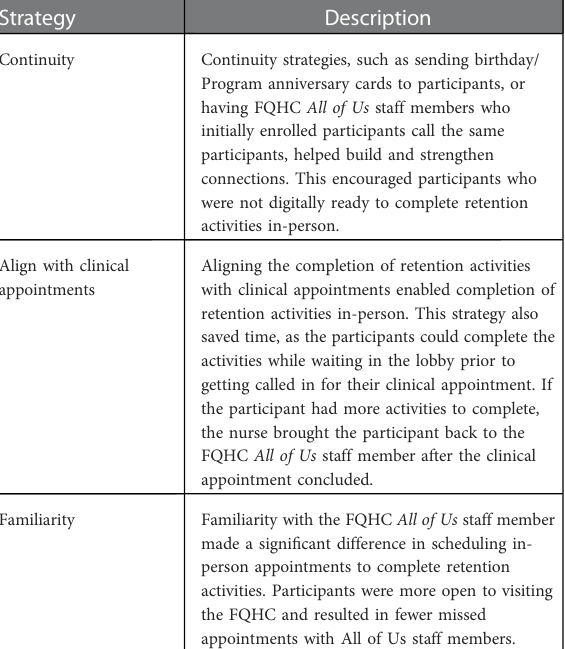
TABLE 5 Summary of Strategies used by FQHCs for Retaining Participants in All of Us .